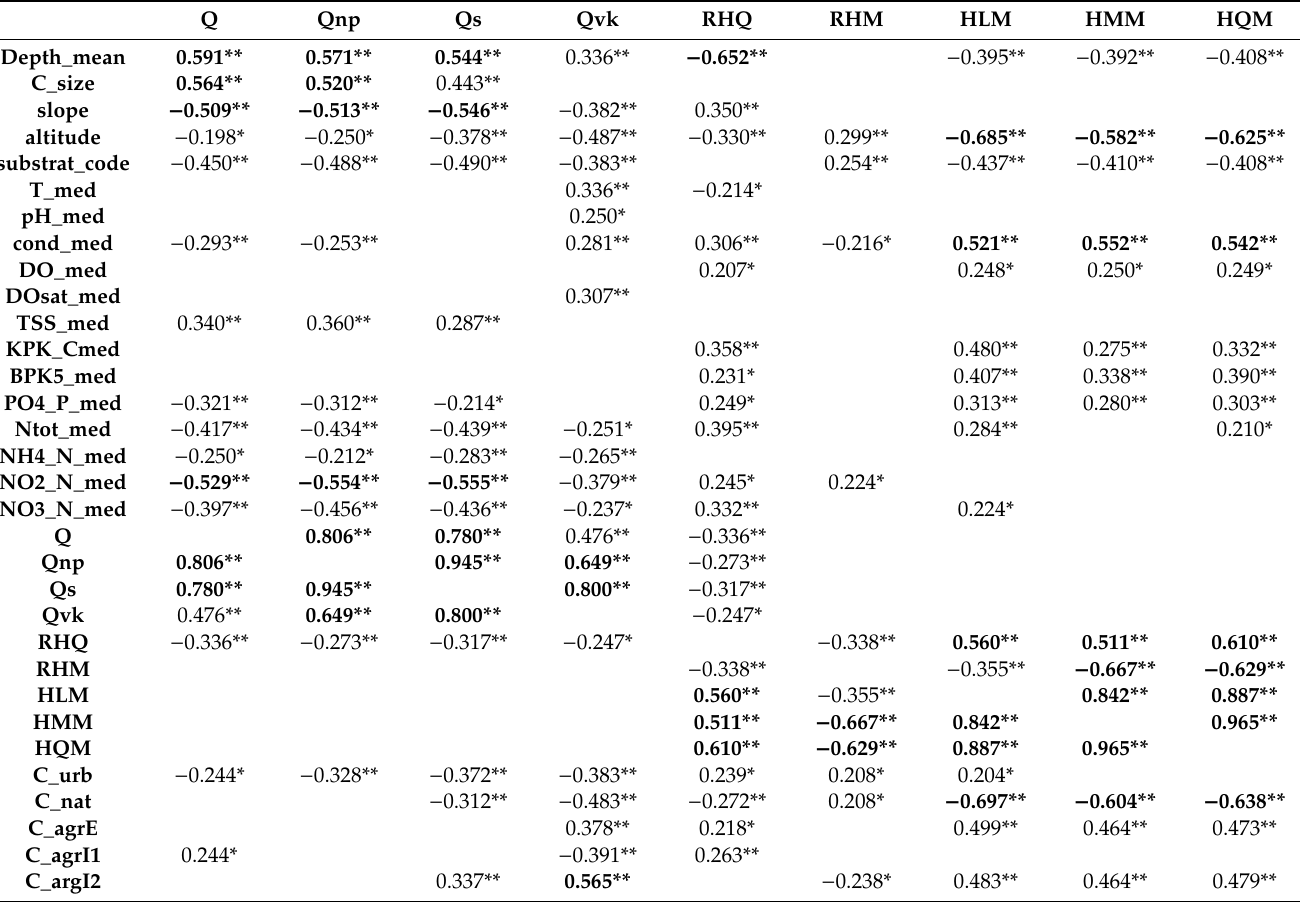
Table A6. Statistically significant Spearman’s correlation coe ffi cients (RSp) for the combinations of hydromorphology variables with variables from all